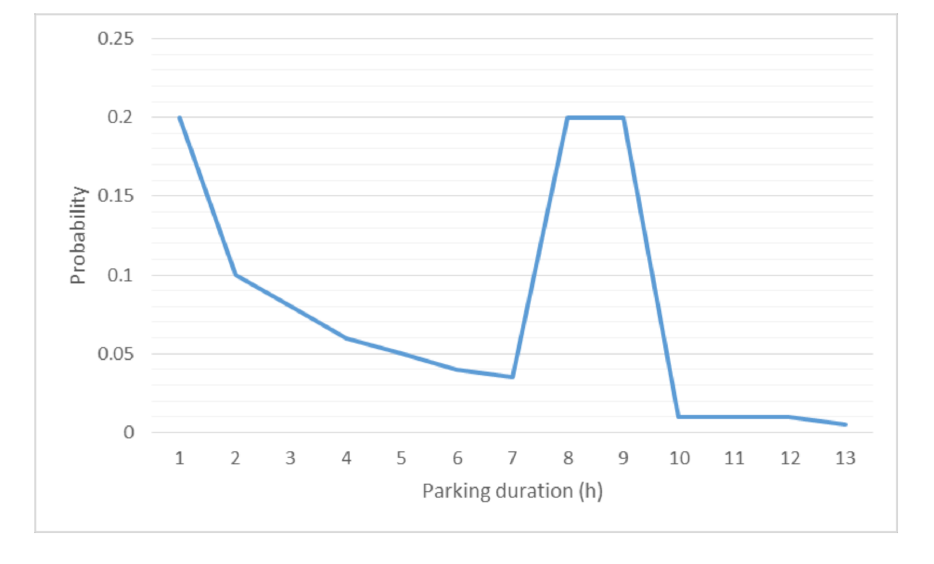
Figure 3. Parking duration probability of PEVs.